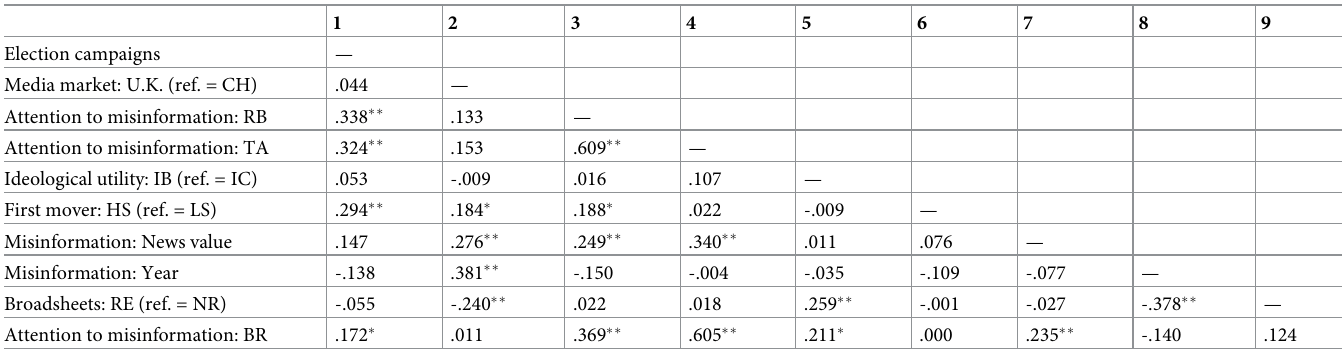
Table 3. Bivariate correlations (political journalism).